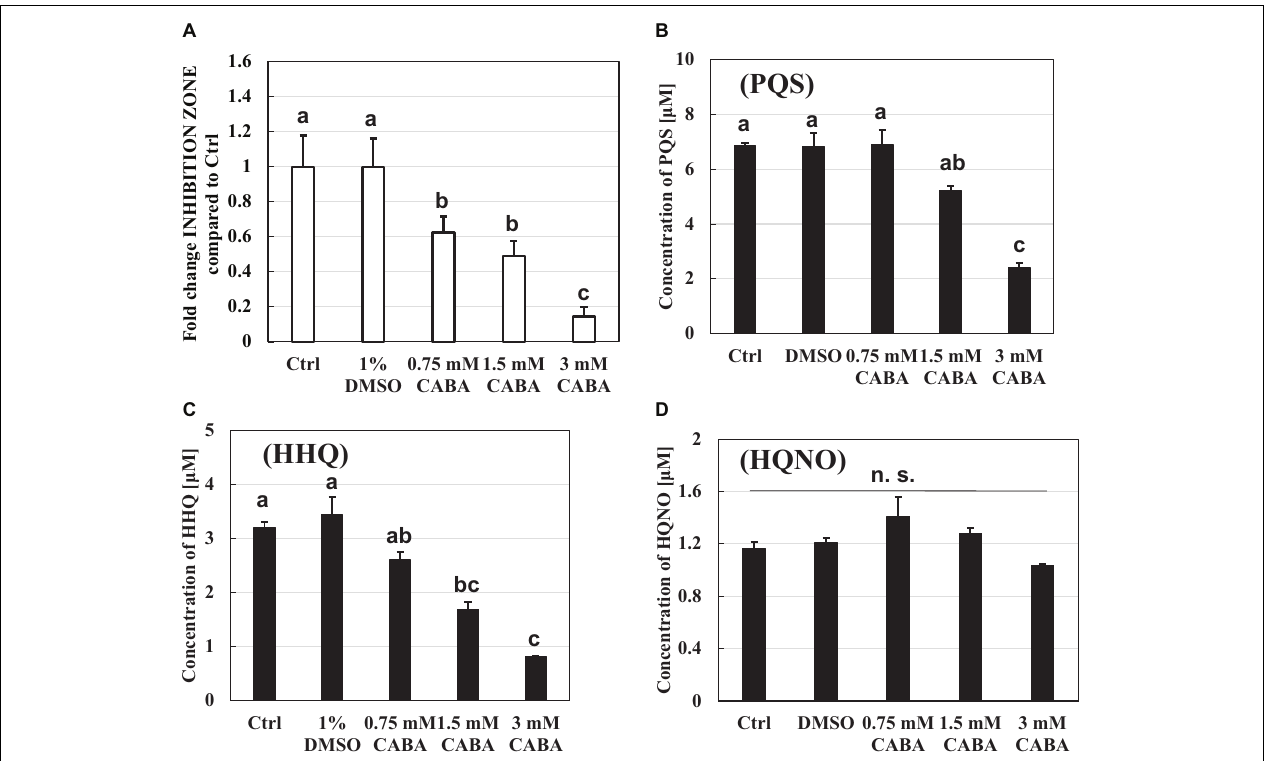
FIGURE 6 | Effect of a pqs quorum-sensing inhibitor, 2-amino-6-chlorobenzoic acid (CABA), on the predation inhibition by Pseudomonas aeruginosa and the production of PQS, HHQ, or HQNO. (A) The reduction of predation inhibitory effect in the presence of CABA. The predation plate assays using a mixture of Bdellovibrio bacteriovorus 109J and Escherichia coli BW25113 were conducted at 30 ◦ C for 3 days in the presence of quinolone compounds extracted from the culture of P. aeruginosa wild type containing 0, 0.75, 1.5, or 3 mM of CABA. (B) PQS, (C) HHQ, and (D) HQNO concentration in the extracts of bacterial culture of P. aeruginosa PA14 after incubation at 37 ◦ C and 120 rpm for 10 h under LB medium with 0, 0.75, 1.5, or 3 mM of CABA. The concentration of HHQ extracted was determined by LC-QTOF-MS. Ctrl and 1% DMSO mean that each sample from the culture uses only LB medium or uses LB with 1% DMSO as solvent control. PQS, Pseudomonas quinolone signal, 2-heptyl-3-hydroxy-4(1H)-quinolone; HHQ, 2-heptyl-4-quinolone; HQNO, 2-heptyl-4-quinolinol 1-oxide. n = 3. The value among each sample with different letters is significantly different ( p < 0.05). n = 3. n. s., not